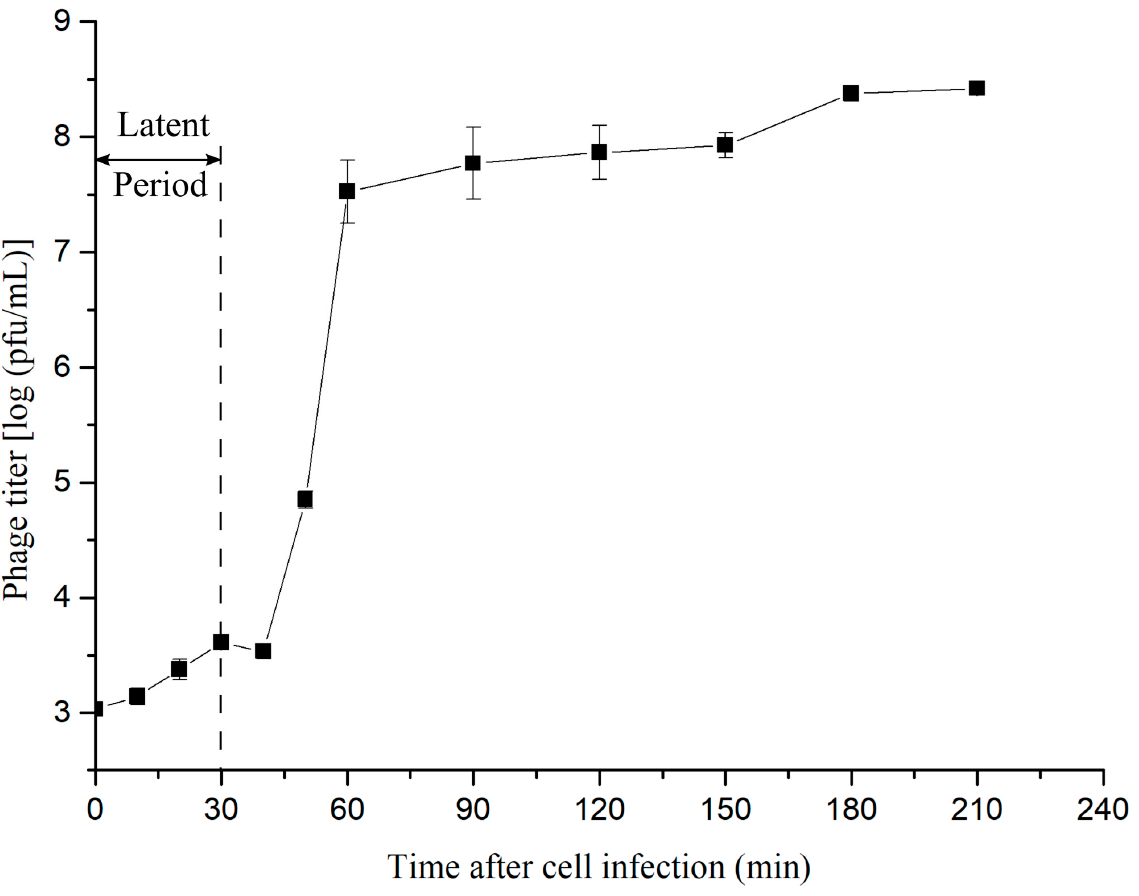
Figure 5. One-step growth curve. All the experiments were conducted at MOI = 0.001 with